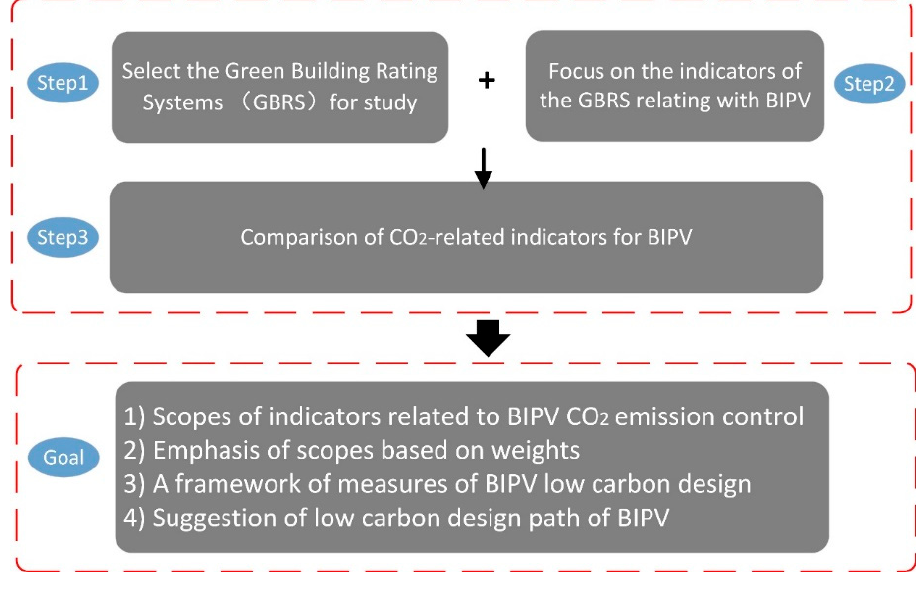
Figure 1. The study schema .